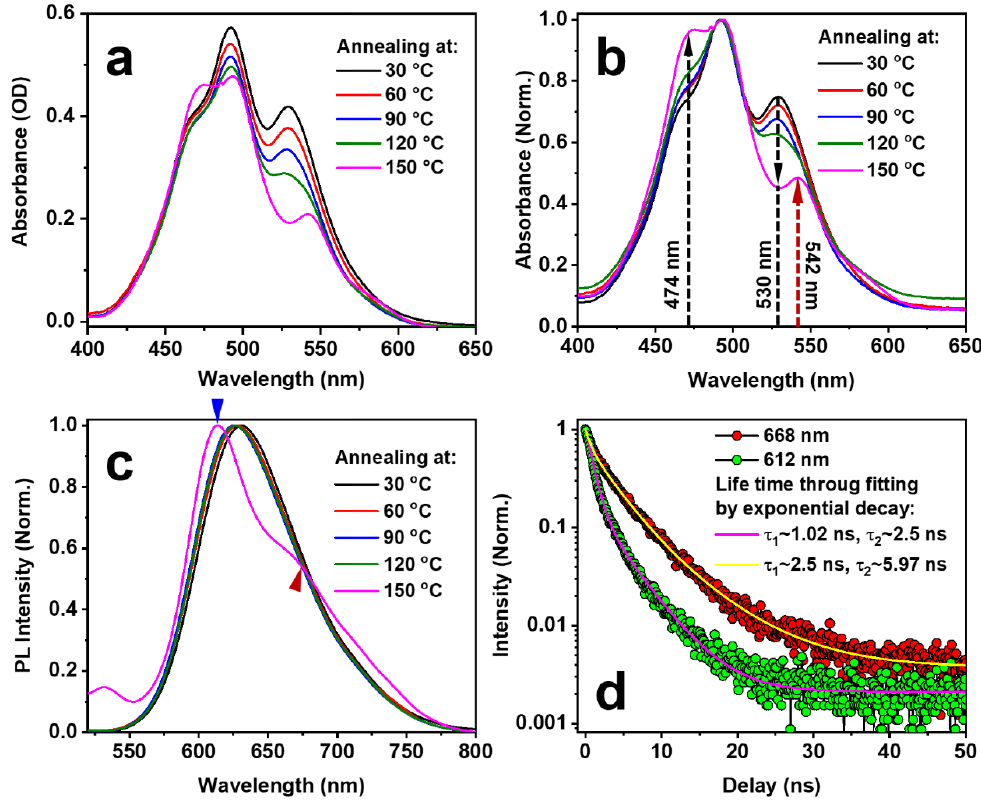
Figure 3. ( a ) Absorption spectra measured at different annealing temperatures. ( b ) Normalized absorption spectra in ( a ). ( c ) Normalized PL spectra measured at different annealing temperatures. ( d ) Fluorescence lifetime at 612 (blue triangle in ( c )) and 668 nm (red triangle in ( c )) for the sample annealing at 150 ◦ C for 10